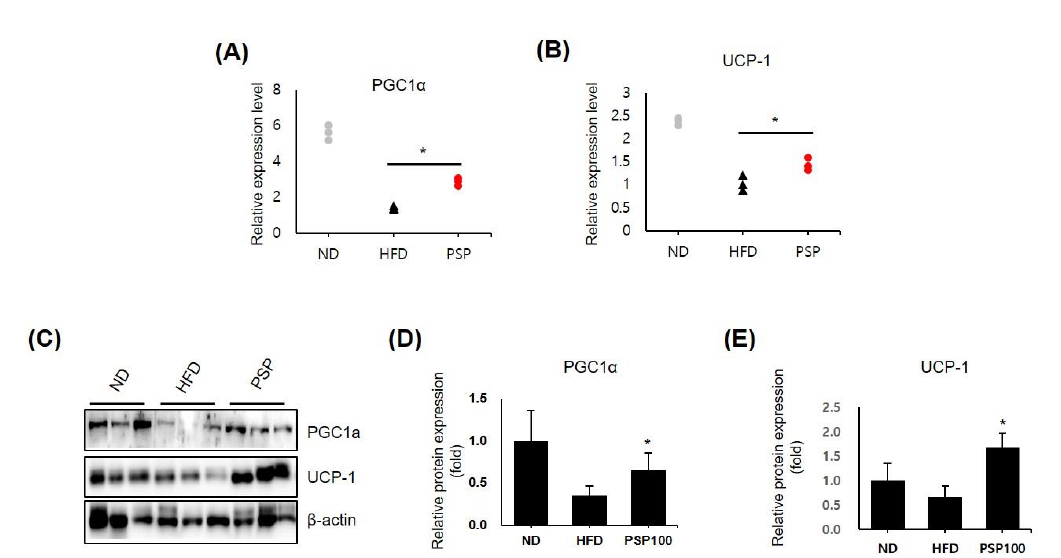
Figure 3. Effects of PSP in the expression of browning-related genes: ( A , B ) The mRNA levels of PGC1 α ( A ) and UCP-1 ( B ) in the iWATs from the ND, HFD, and PSP mice ( n = 3/group). The expression level of each gene was normalized to that of β -actin and expressed relative to the HFD control. ( C – E ) The Western blots ( C ) of PGC-1 α and UCP-1 and the quantification of these proteins ( D , E ). * p < 0.05, the significance of the difference from the HFD group. The bar graphs show mean ± SD of the three mice per group.